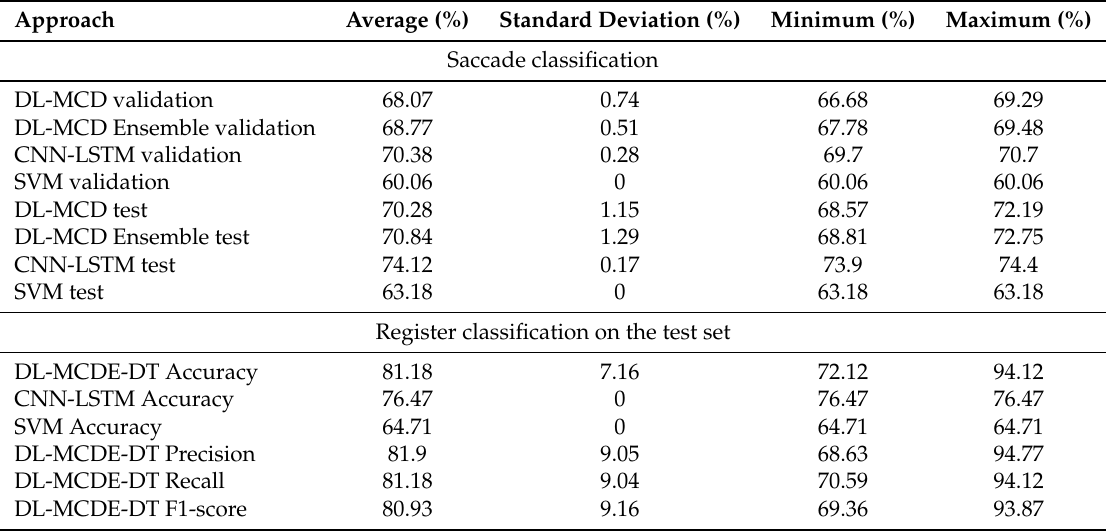
Table 2. Summary of classification performance obtained for various combinations of approaches and for other methods.